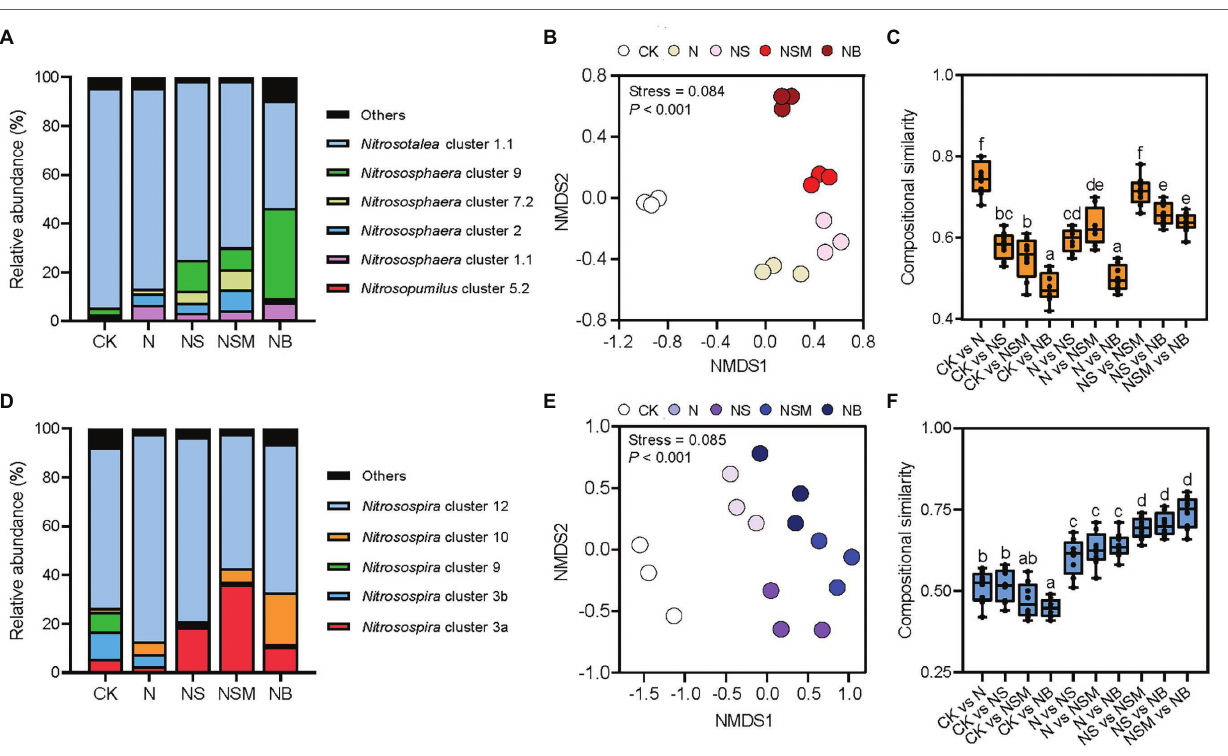
Nitrososphaera cluster 9 (0.18 and 2.27%) and AOB Nitrosospira cluster 10 (0.01%) in the OM+ were identified as module hubs ( Table 2 ; Figures 4A,B ). The Nitrosospira cluster 12 was mainly